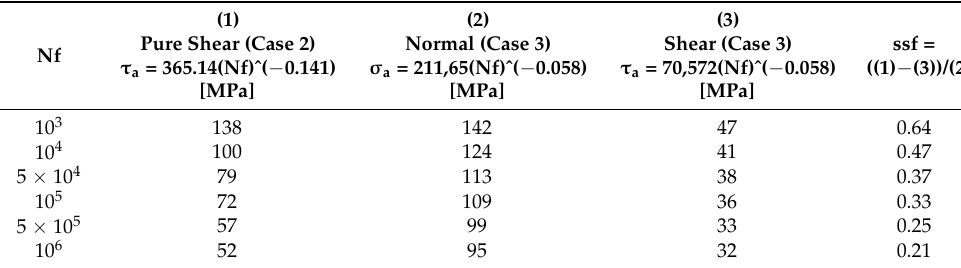
Table 6. ssf results for Case 3—AZ31B-F.